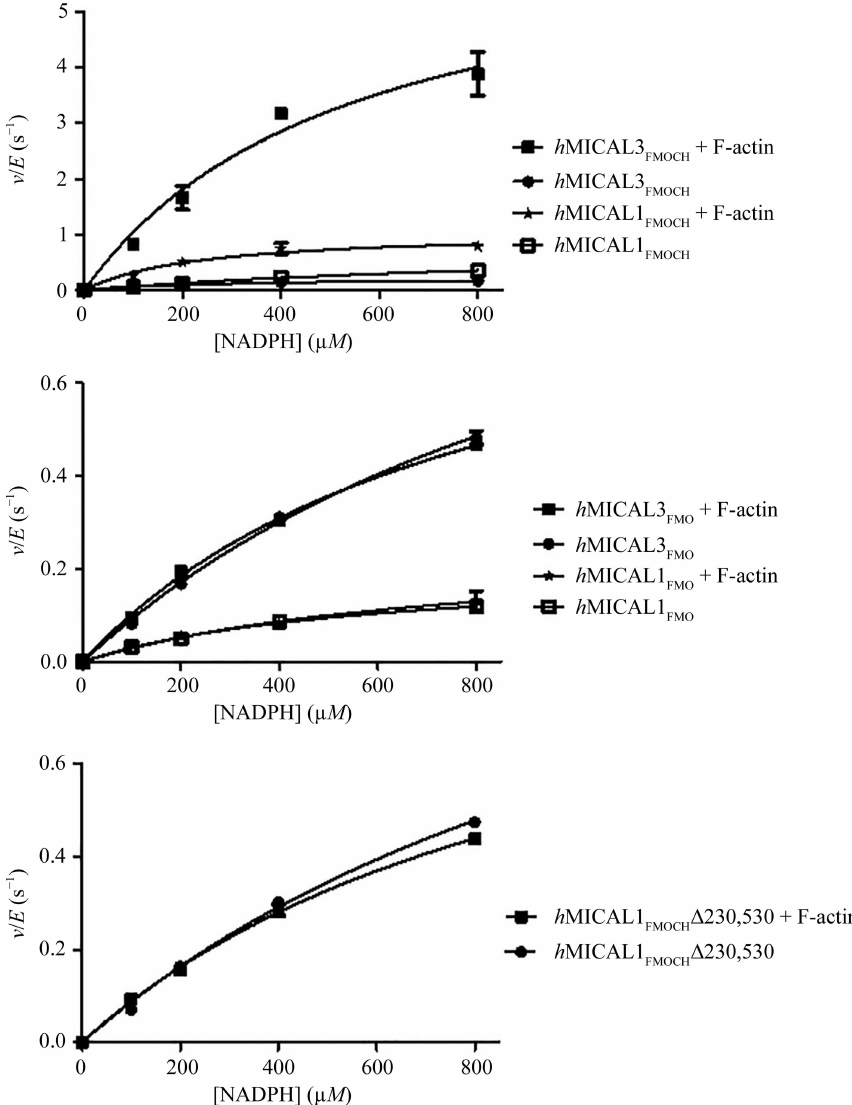
Figure 3 Steady-state kinetic analysis of MICAL forms. Initial velocity ( v ) was measured in an F-buffer- based mixture at various NADPH concentrations. The initial velocity of each reaction was divided by the total enzyme concentration ( E , 400 n M